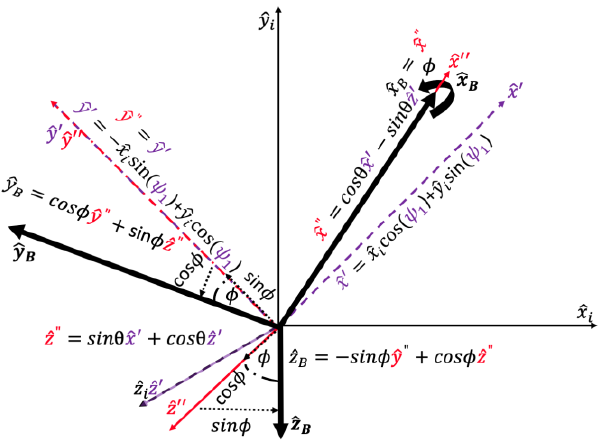
Figure 4. 3-rotation about the x′′̂ and 𝑥 𝑏 ̂ axes [23].